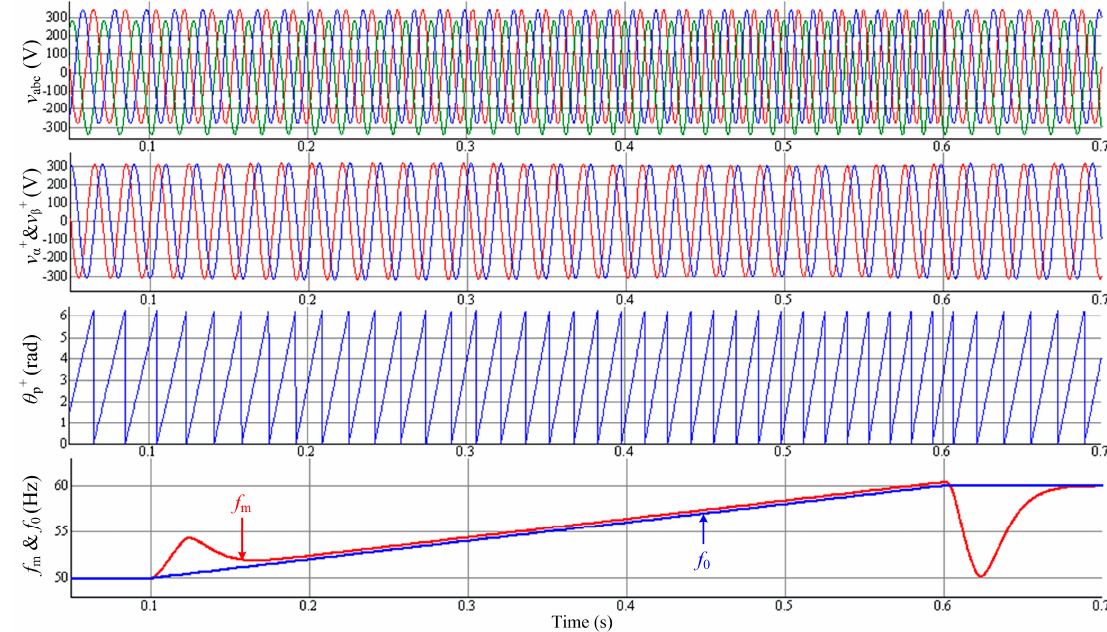
Figure 13. The experimental results under ramp-changed frequency.